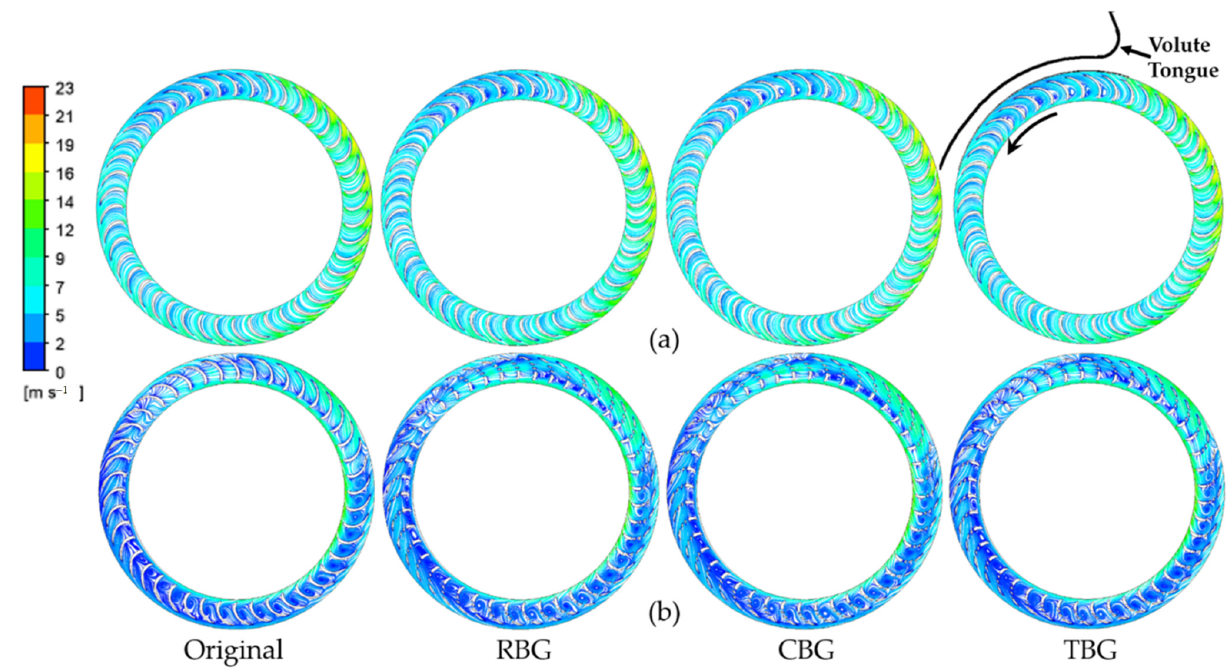
Figure 16. Velocity streamline distributions in the impeller of multi-blade centrifugal fans with different blade tip groove shapes: ( a ) at the section 𝑃 (cid:3040)(cid:3036)(cid:3031) and ( b ) at the section 𝑃 (cid:3047)(cid:3042)(cid:3043) . different blade tip groove shapes: ( a ) at the section P mid and ( b ) at the section P top